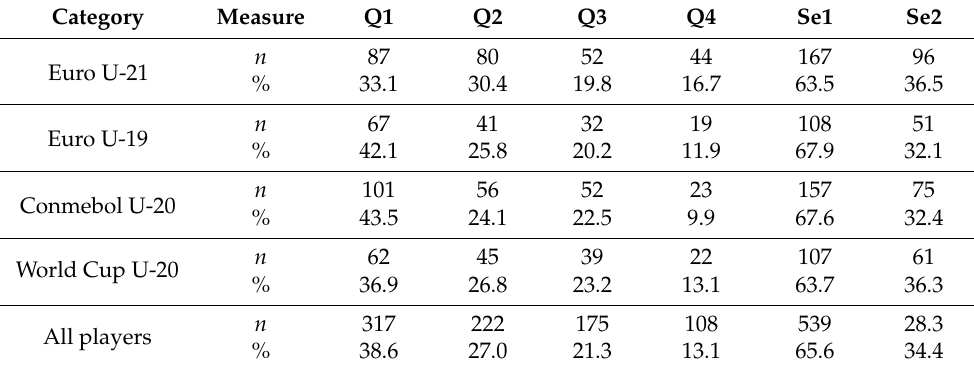
Table 1. Birthdate distributions of international youth championships (2017–2019) according to their quartile or semester of